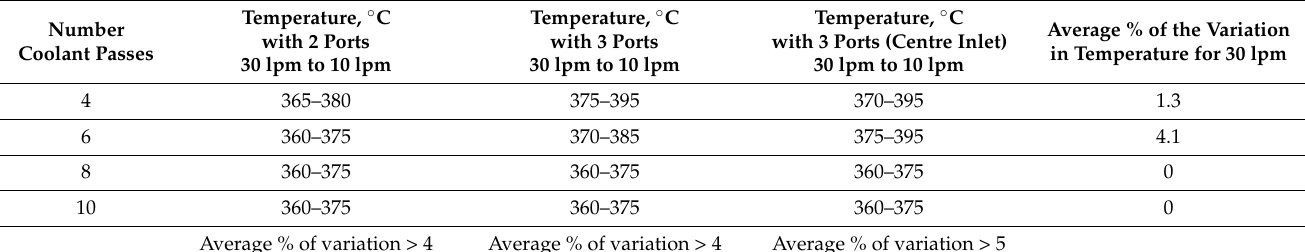
Table 7. Rate of temperature variation, with respect to the number of passes and coolant flow rate [40].